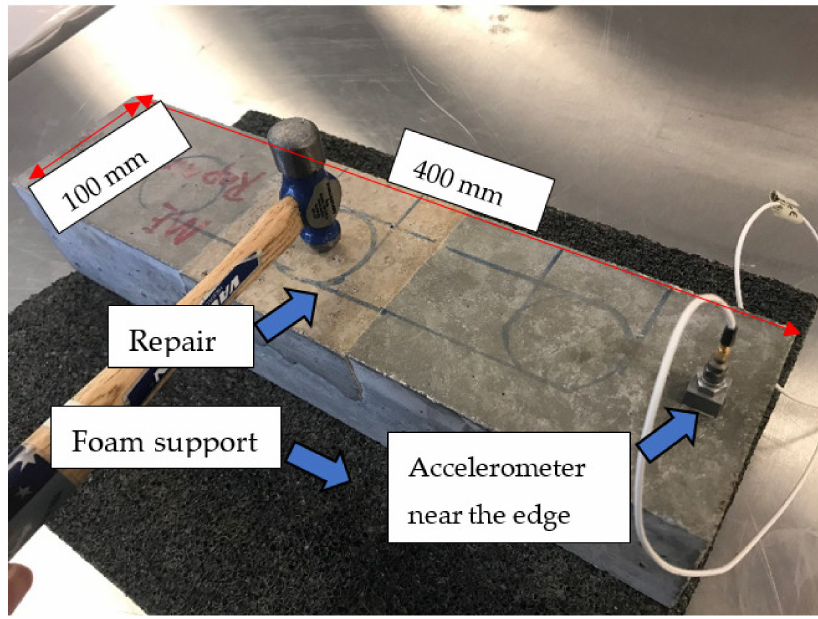
Figure 6. Resonant frequency test